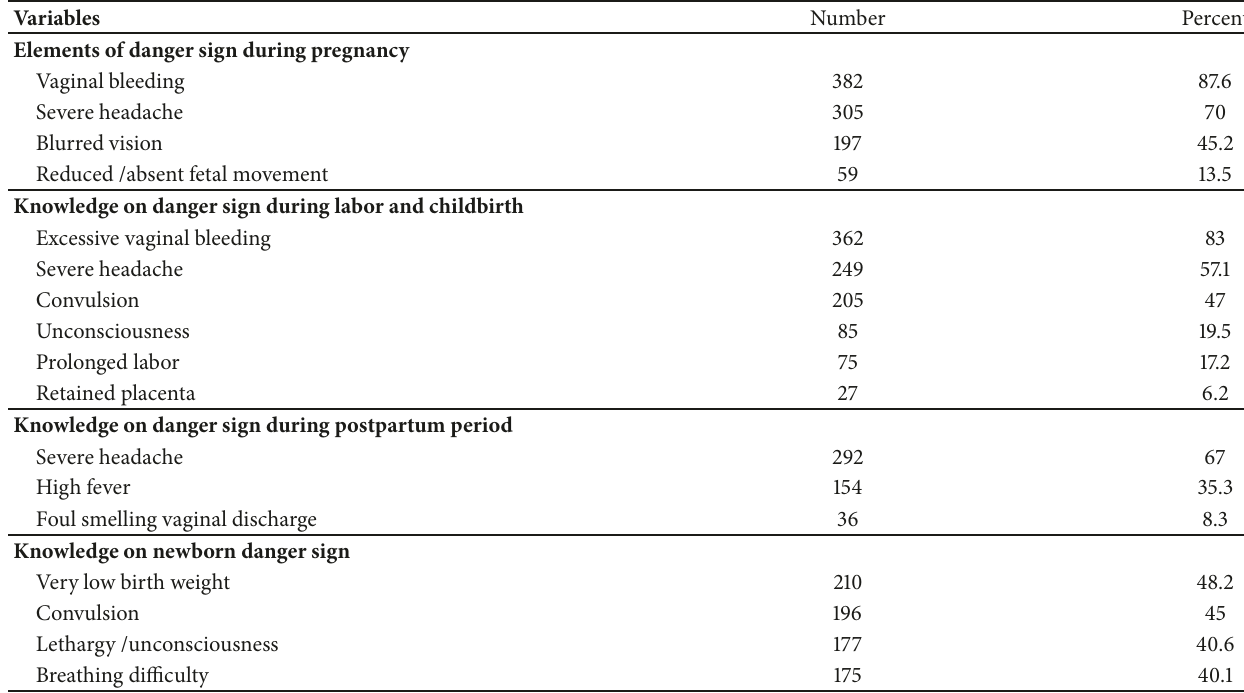
Table 3: Danger signs of antepartum, intrapartum, postpartum, and new born mentioned by pregnant mothers in Debrmarkos town, Northwest Ethiopia,